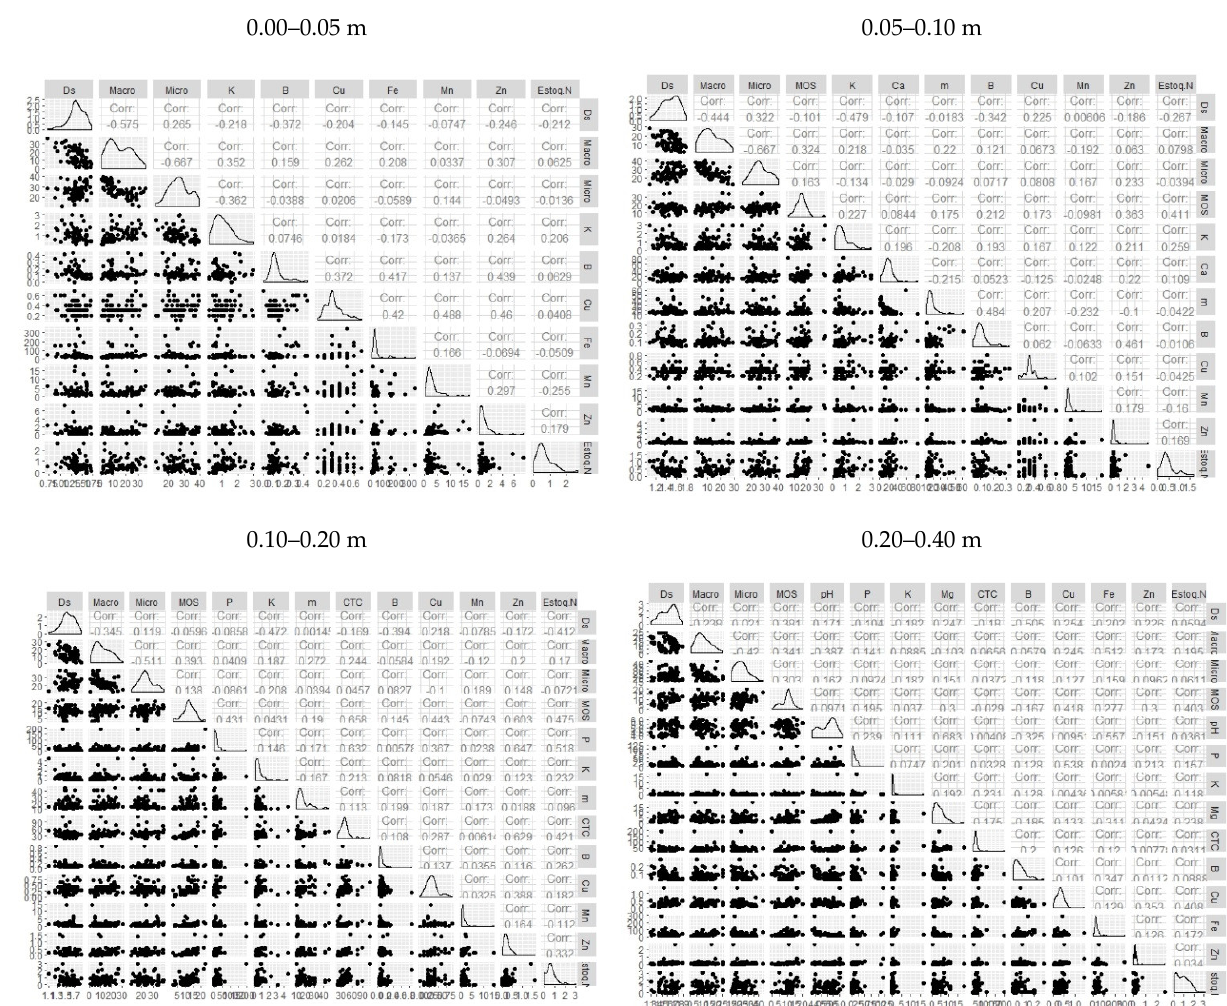
Figure 6. Data dispersion, frequency distribution, and Pearson correlation coefficient of variables selected at each depth to be used in the Random Forest predictive model to predict soil carbon stock for different land use systems. Bd—bulk density (kg dm −3 , Macro—macroporosity (m 3 m −3 ), Micro—microporosity (m 3 m −3 ), SOM—soil organic matter (g dm −3 ), pH—potential hydrogen, P—available phosphorus content (mg dm −3 ), K—potassium content (mmol c dm −3 ), Ca—calcium content (mmol c dm −3 ), Mg—magnesium content (mmol c dm −3 ), m—saturation by aluminum (mmol c dm −3 ), CEC—cation-